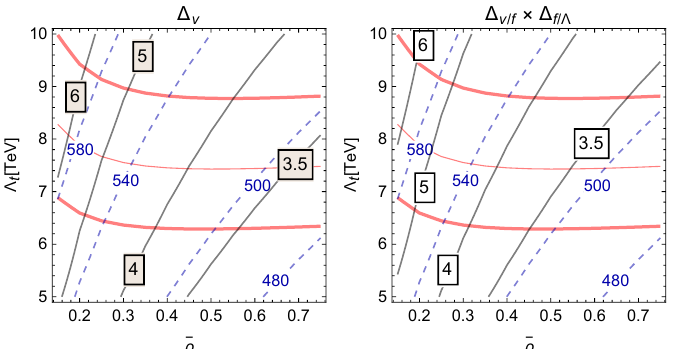
Figure 4 . Solid contours denote the total tuning (cid:1) v of v with respect to all parameters added in quadrature (left) and the factorized approximation (cid:1) (cid:2) (cid:1) f (right) as a function of (cid:22) (cid:26) and (cid:3) t for v=f (cid:15) (cid:0) . The parameters (cid:12)xed numerically are reported in table 1. The red band denotes the Higgs mass window (122 GeV, 128 GeV). The dashed line denotes the scale f in unit of GeV. Compared to a vanilla Twin Higgs model, we (cid:12)nd a factor of 8{15 improvement in the tuning across this parameter space; see the text for further details.